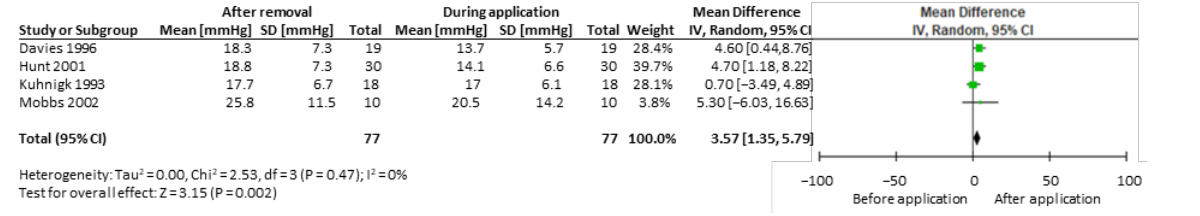
Figure 2. Forest plot of ICP changes during application of cervical collars in TBI patients identified by the systematic search.